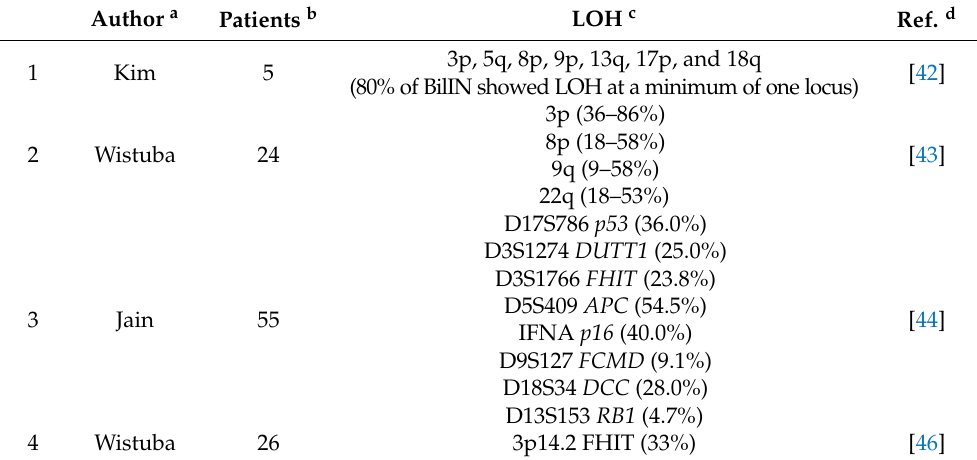
Table 3. Reported loss of heterozygosity (LOH) in biliary intraepithelial neoplasia